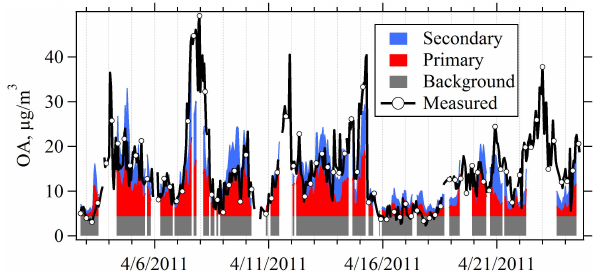
Fig. 6. Time series of measured and calculated concentrations of organic aerosol during the Changdao